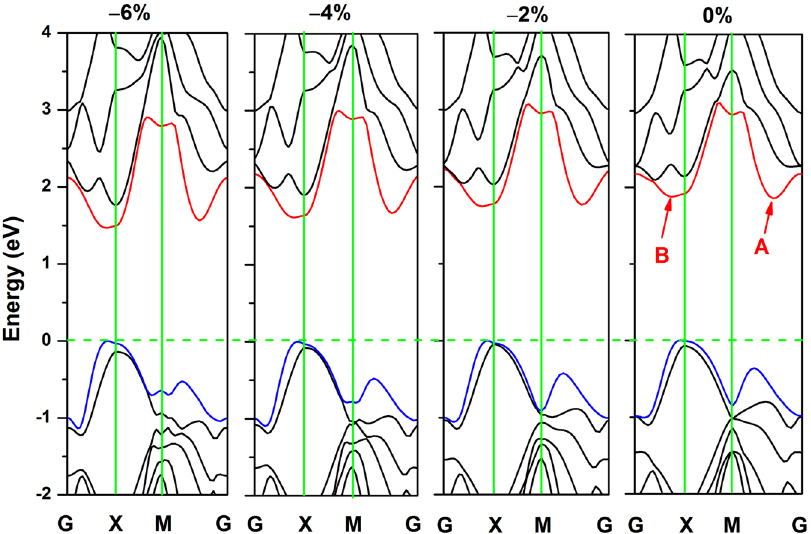
Figure 7. Strain-manipulated direct-to-indirect band gap in a 2D penta-BP 5 monolayer with compressive strains of 0%, − 2%, − 4% and − 6%. The Fermi energy was set to